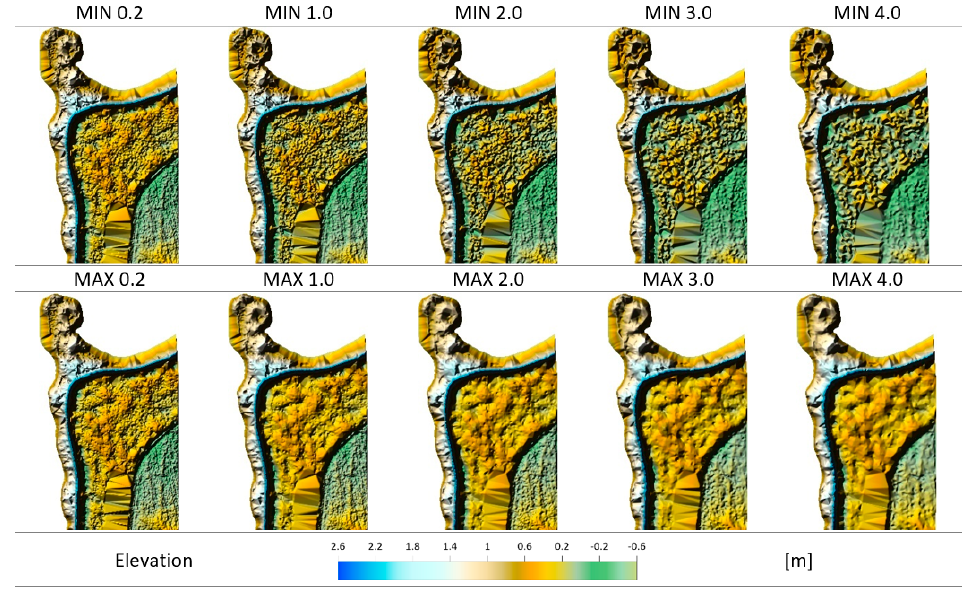
Figure 13. Comparison of DTMs used for the triangulation method.